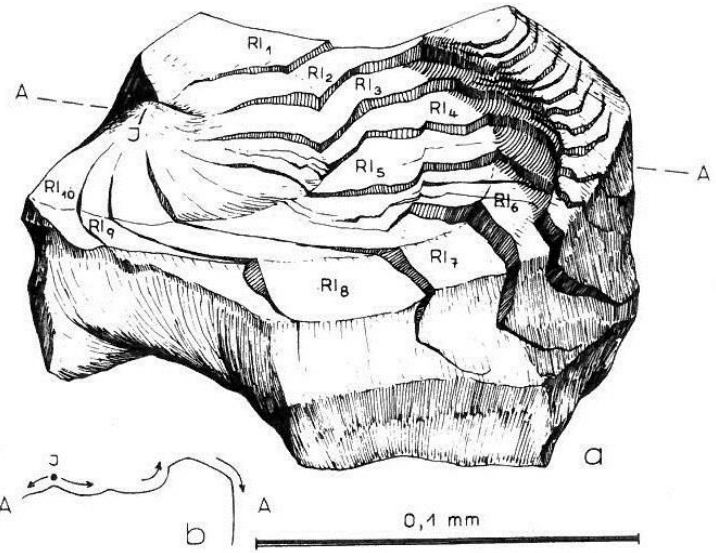
Figure 25. Fracture documentation of a small regolith fragment.